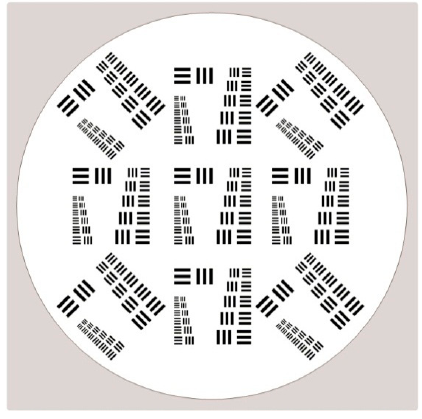
Figure 15. The pattern for the resolution mask used for the experiment. The nine modules are distributed in graphic arrays. Each module contains line pairs with group numbers 1 and 2.